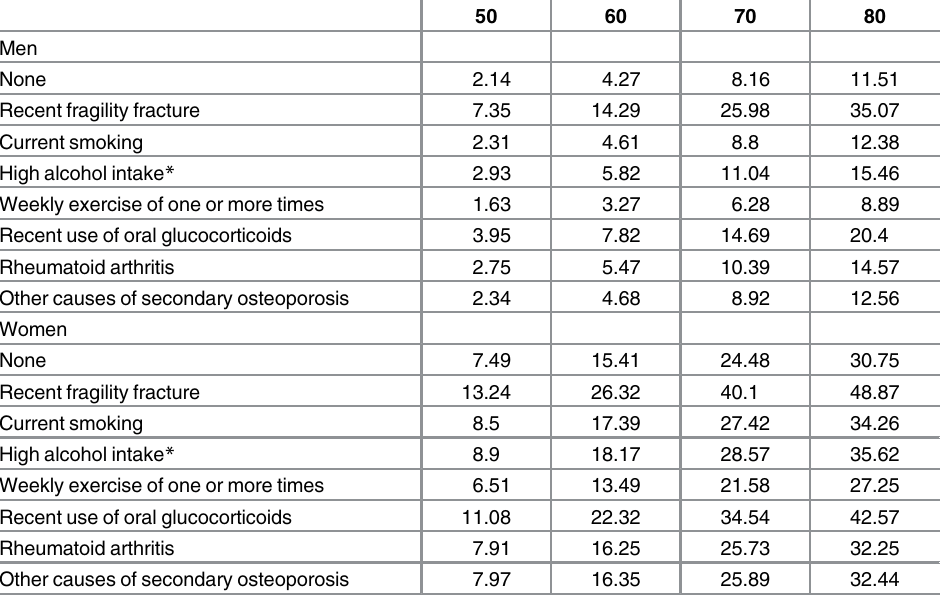
Table 4. 7- year osteoporotic fracture risk * with normal BMI according to age and the absence or presence of single clinical risk factors.